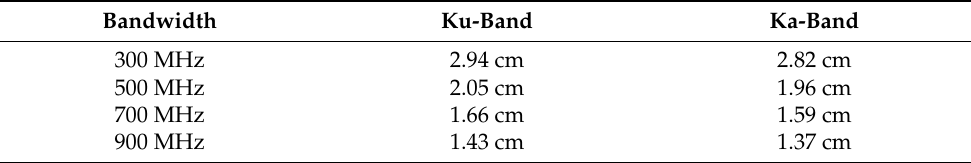
Table 3. 1 Hz theoretical height measurement precision under different bandwidth setting.